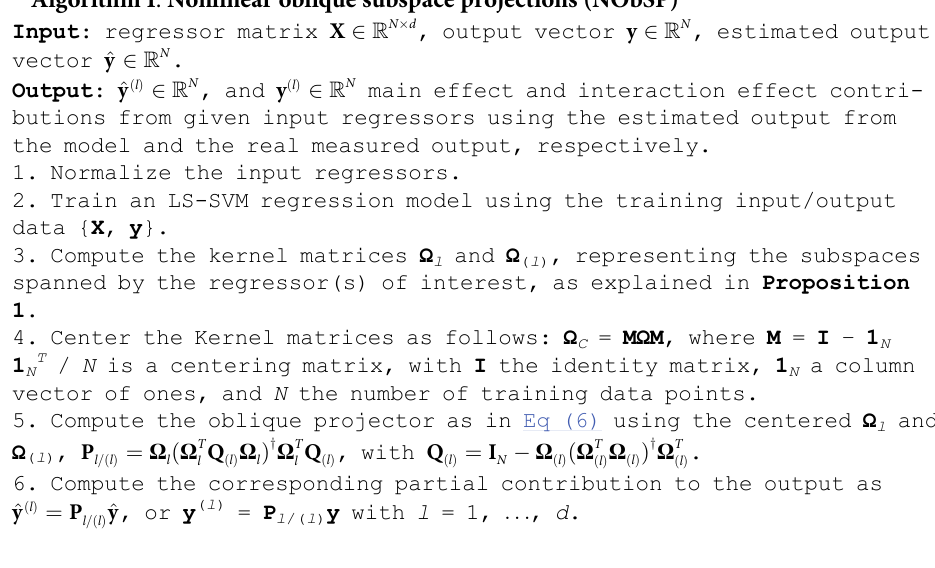
Algorithm I . Nonlinear oblique subspace projections